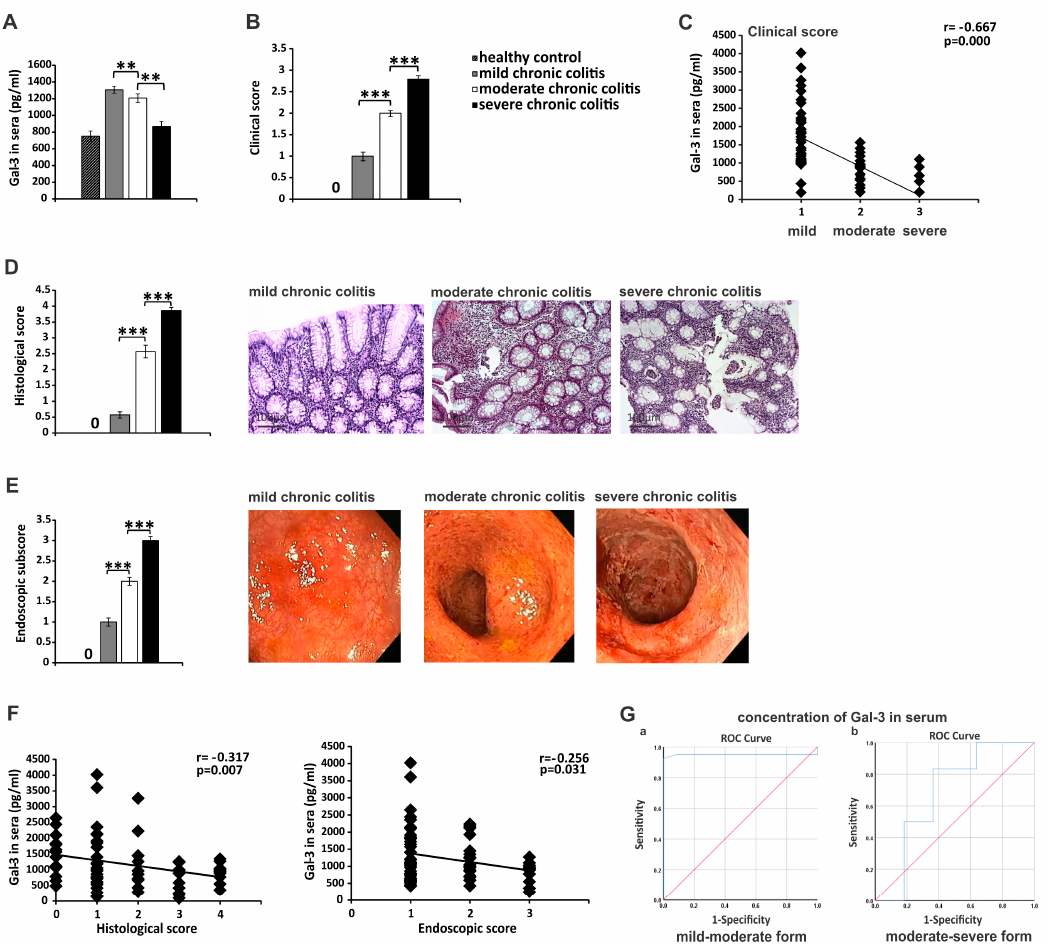
Figure 7. Serum Gal-3 may serve as a valuable marker for monitoring the progression of UC. The serum levels of Gal-3 ( A ), clinical score ( B ), histological score ( D ), endoscopic score ( E ) in UC patients with mild, moderate or severe forms of UC. Correlation between clinical score and serum levels of Gal-3 ( C ). Representative histological sections ( D , magnification of 200 × ) and endoscopic images ( E ) of UC patients with mild, moderate, or severe forms of UC. ( D ). Correlation between serum levels of Gal-3 and histological or endoscopic score ( F ). ROC curve illustrate the specificity and sensitivity of Gal-3 serum concentration, comparing mild chronic colitis with moderate chronic colitis (left panel) and specificity and sensitivity of sera Gal-3, comparing moderate chronic colitis with severe chronic colitis (right panel) ( G ). Mean ± standard error of the mean; ** p < 0.01; *** p < 0.001.